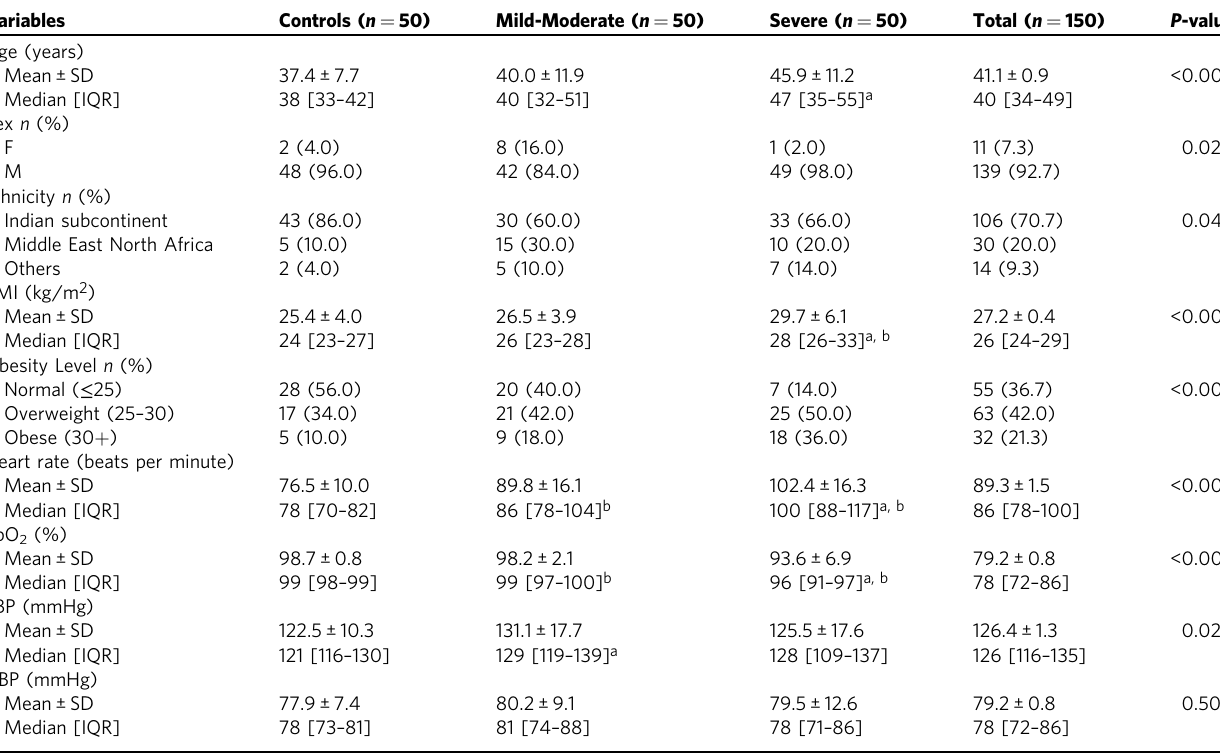
Table 1 Characteristics of patients with COVID19 and